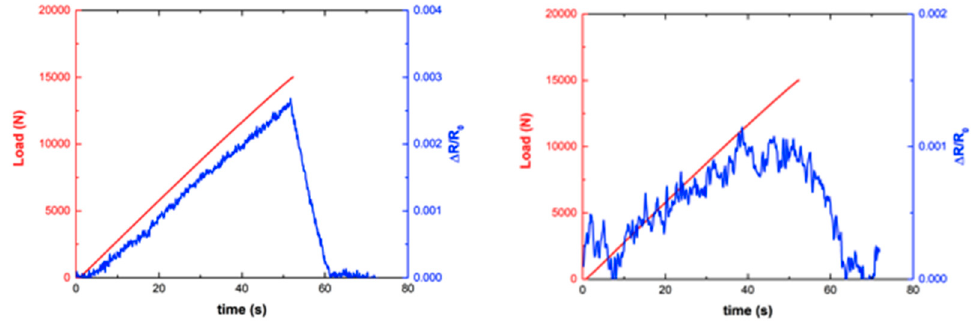
Figure 7. The electrical response as a function of the mechanical load for channels 2 ( left ) and 10 ( right ). Channel 2 was outside the bonded area, while channel 10 was inside the bonded region (see Figure